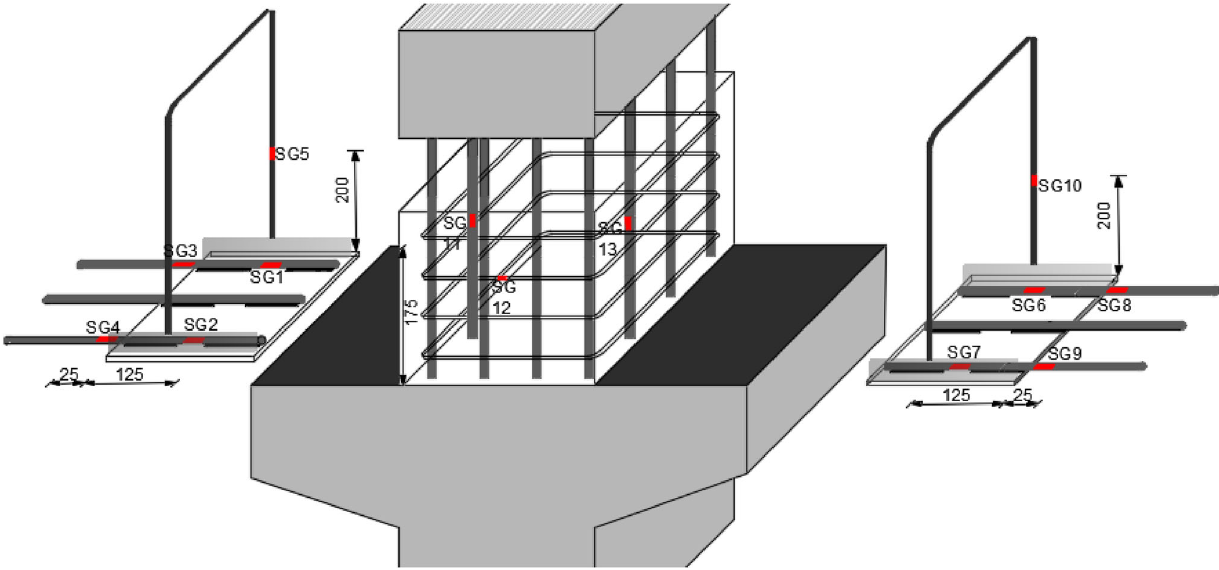
Fig. 13 Installation of strain gauges on beams and column reinforcing bars (units in